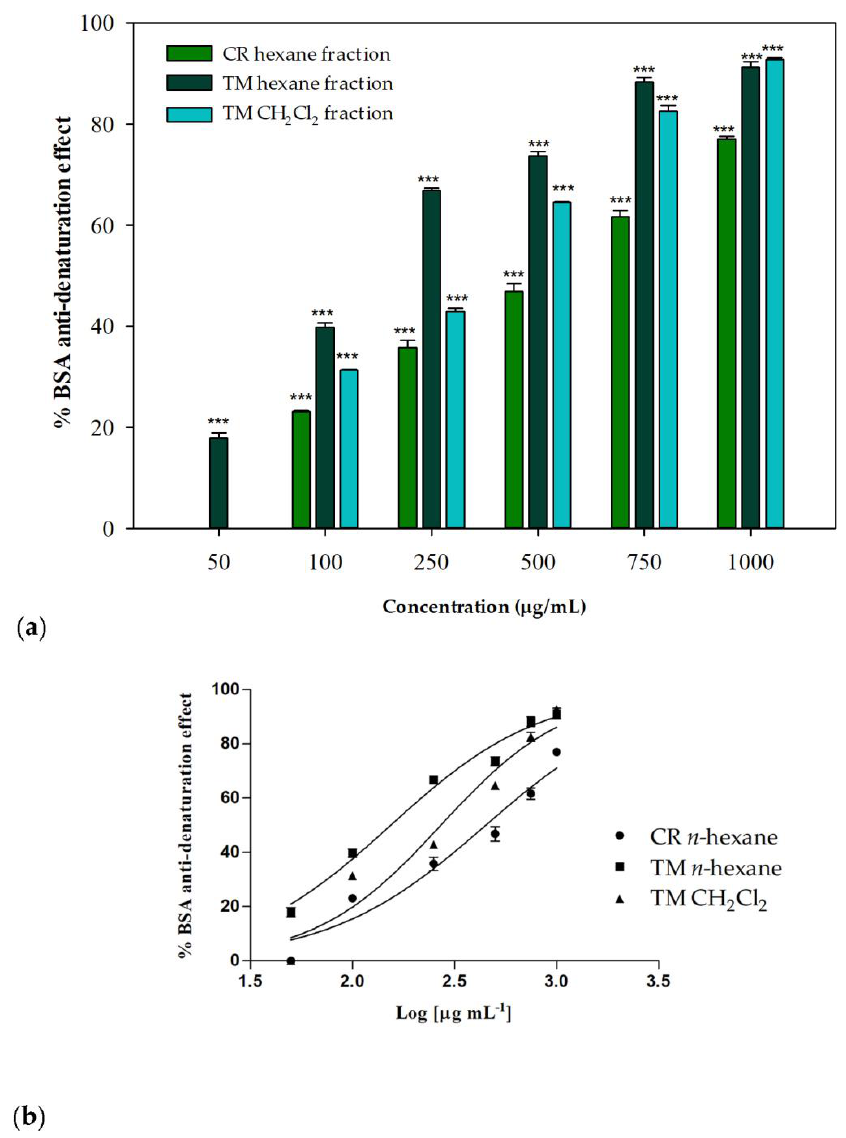
Figure 5. ( a ) Inhibition of BSA heat-induced denaturation. Data were expressed as mean ± S.E.M. (n = 3). Diclofenac sodium was used as a positive control. CR: C. ruber (L.) DC.; TM: T. majus L. Mean values of samples showing significant difference compared to the control (untreated 3.5% BSA water solution) were denoted with *** p < 0.001 (Dunnett’s multiple comparison test). ( b ) Nonlinear regression analyses.